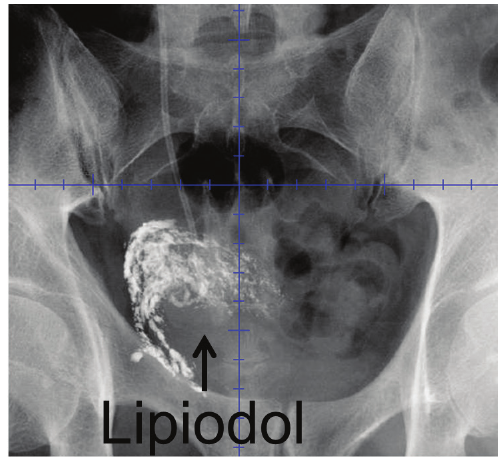
Figure 1B - kV image (anterior view) showing Lipiodol contrast in the tumor bed in the anterior and right lateral bladder walls.